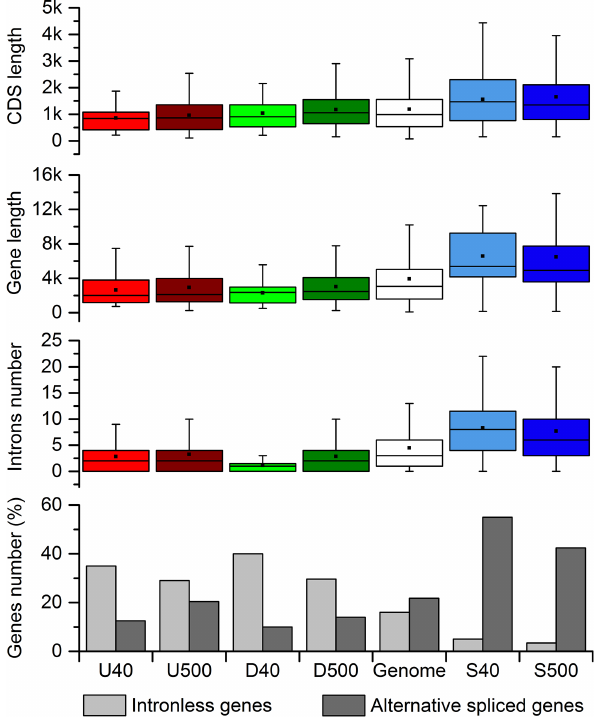
Fig 6. Structural featuresamong gene groups. The groupsare formed by top 40 and 500 ranked up- (U), down-regulated(D), and stable-genes (S) to hypoxia,and genome.The box is determinedby the 25th and 75th percentiles with a line as the medianand a black square as the mean of the data. Error bars extend 1.5 times the interquartile range from the 25th and 75th percentiles. Statistical significances from pairwise comparisons are providedin Tables B and C in S1